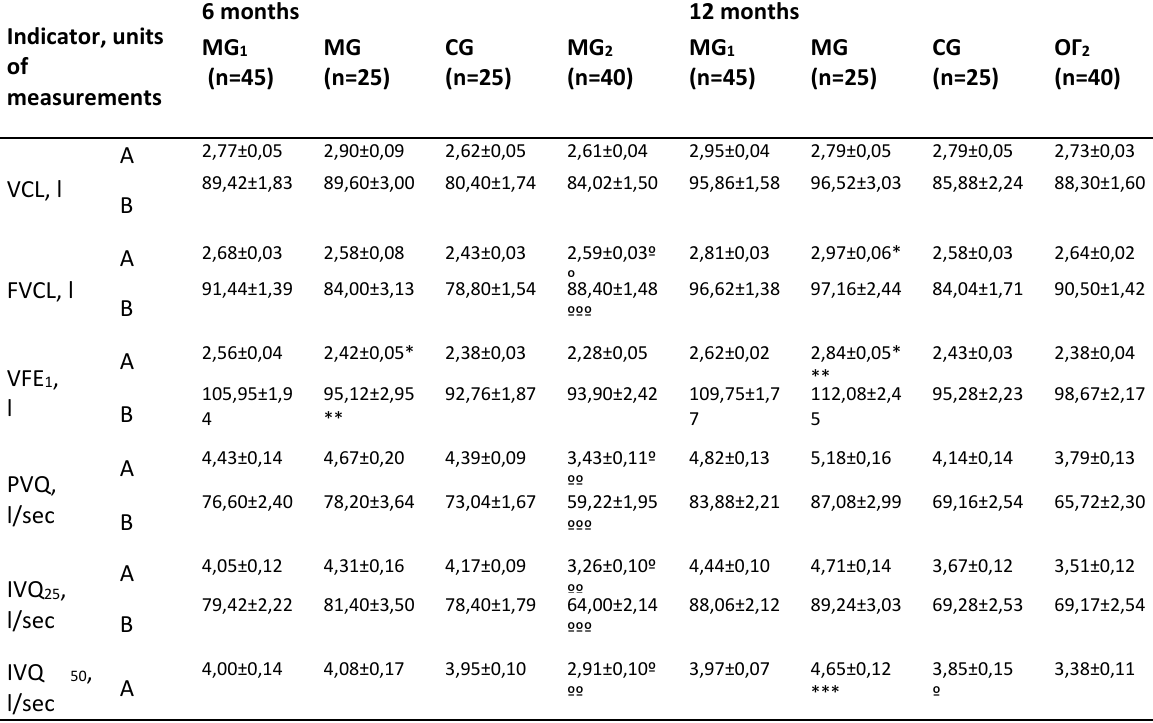
Table 1. Comparison of indicators of women with post mastectomies syndrome at dispensary stage of